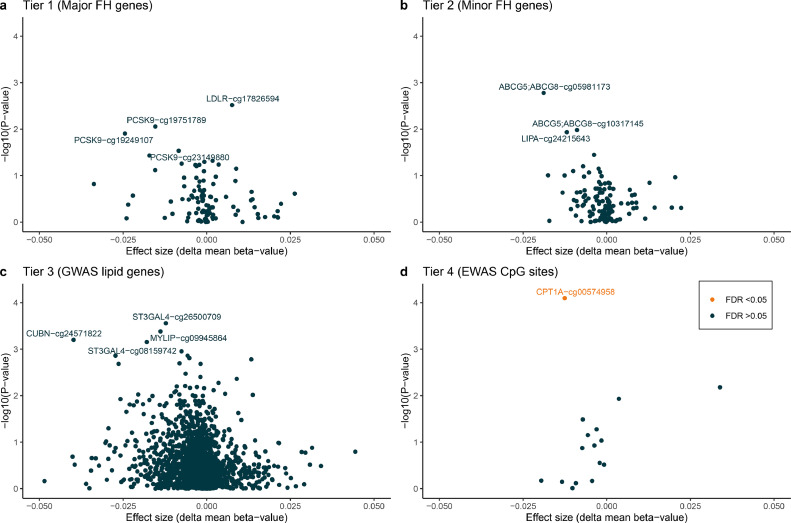
Candidate gene analysisFour tiers of genes were constructed based on literature (genes are listed in Supplementary Table 1). Shown are the difference in methylation (effect size) between FH-mutation negative and FH-mutation positive patients for the four tiers (panels A-D) Only in tier 4 (panel D), one CpG site (CPT1A-cg00574958) was significantly less methylated in FH-mutation negative patients. Significance was defined as a False Discovery rate (FDR) of <0•05. FH, Familial Hypercholesterolemia; GWAS, genome-wide association study; EWAS, epigenome-wide association study.